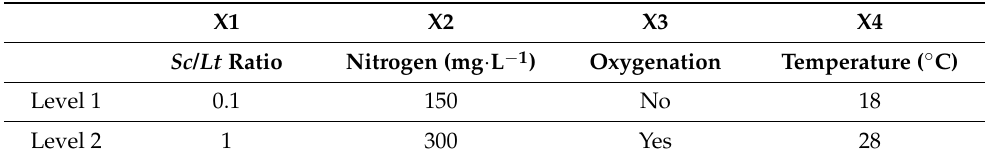
Table 1. Parameters tested in the experimental design.